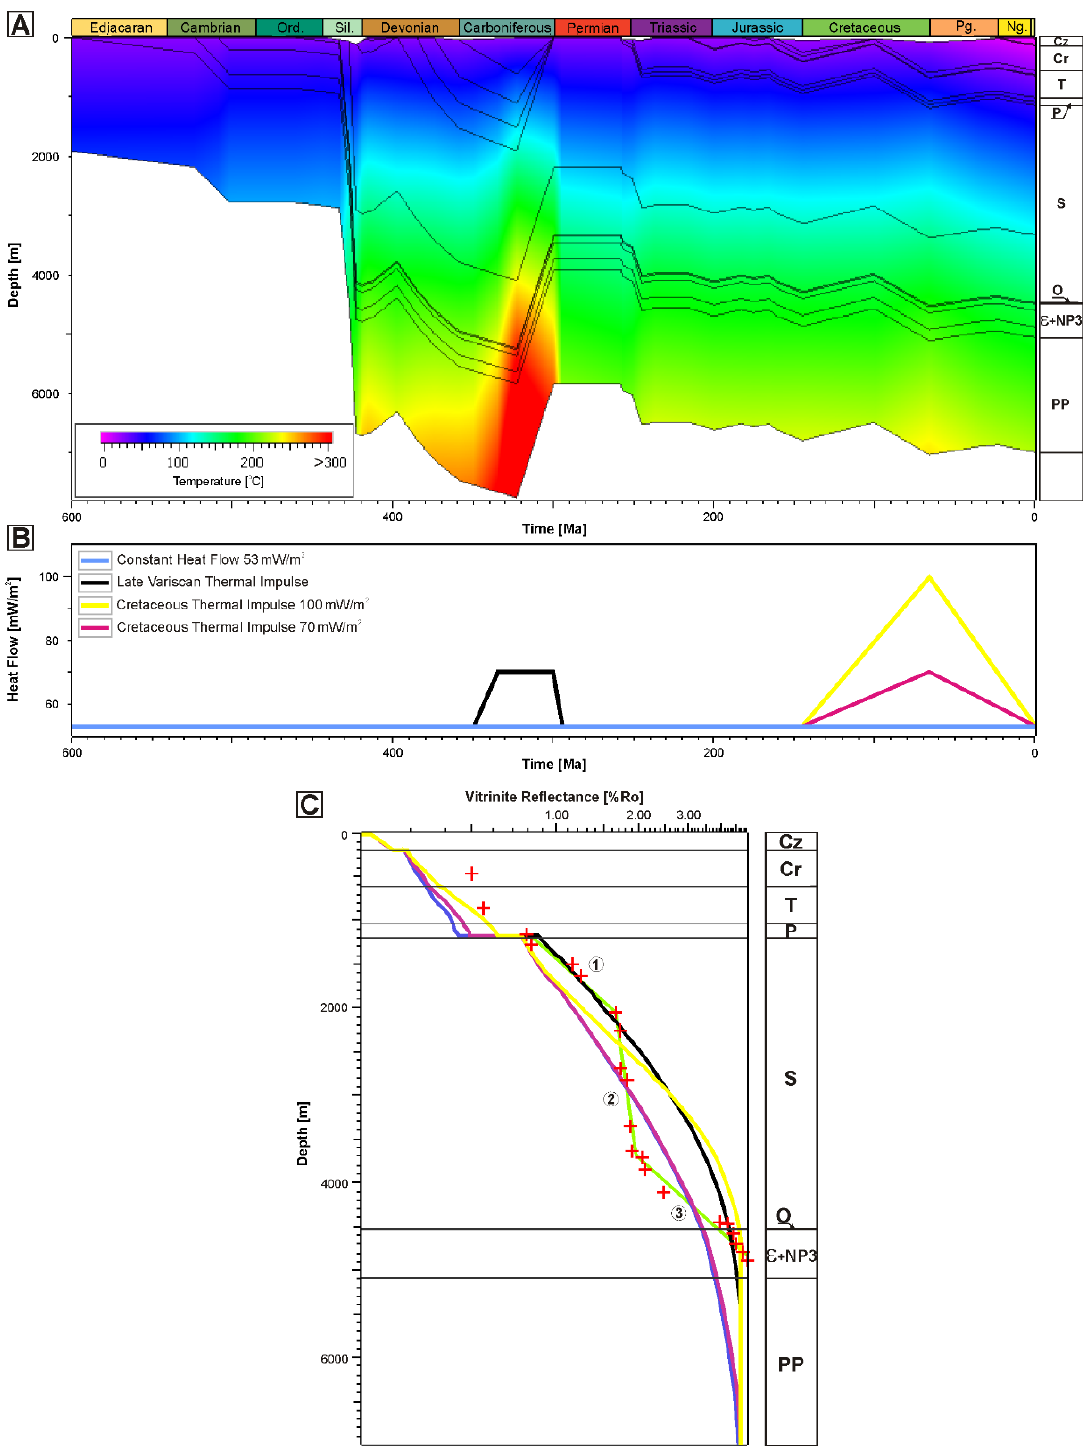
Figure 7. Results of 1D paleothermal modelings: ( A ) Burial and paleotemperature history of sedimentary formations in the Słupsk IG–1 well. ( B ) Considered models of basal heat flow variability through geologic time. ( C ) Fitting of modeled to measured values of vitrinite reflectance for heat flow models presented above. Explanations: red crosses—measured values of vitrinite reflectance [51]. Green line—manual approximation of vitrinite reflectance changes within Paleozoic sediments.